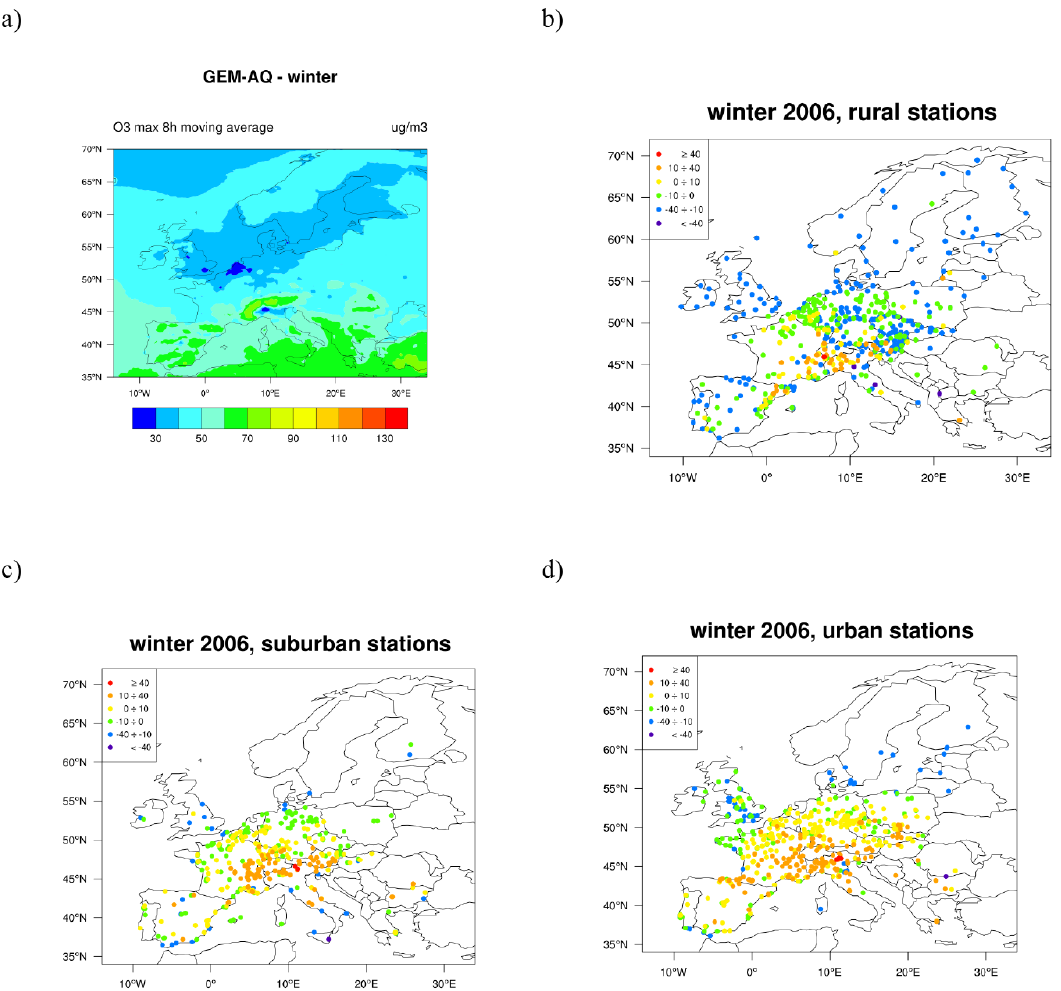
Figure 3. Winter (DJF) maximum 8h running average ozone concentration in µgm − 3 (a) , MBE at rural stations (b) , MBE at suburban stations (c) and MBE at urban stations (d)